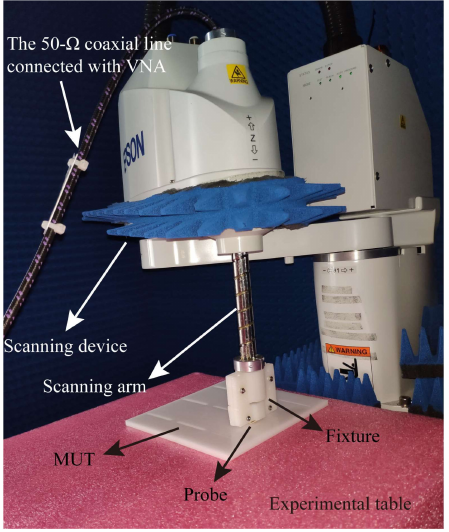
Figure 11. The testing